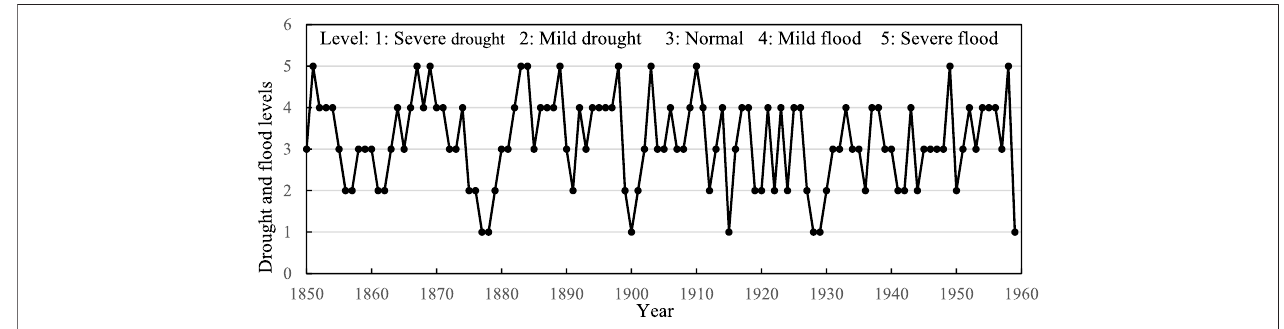
FIGURE 2 | Annual grade sequence of droughts and fl oods in the Qinling mountains from 1850 to 1959.